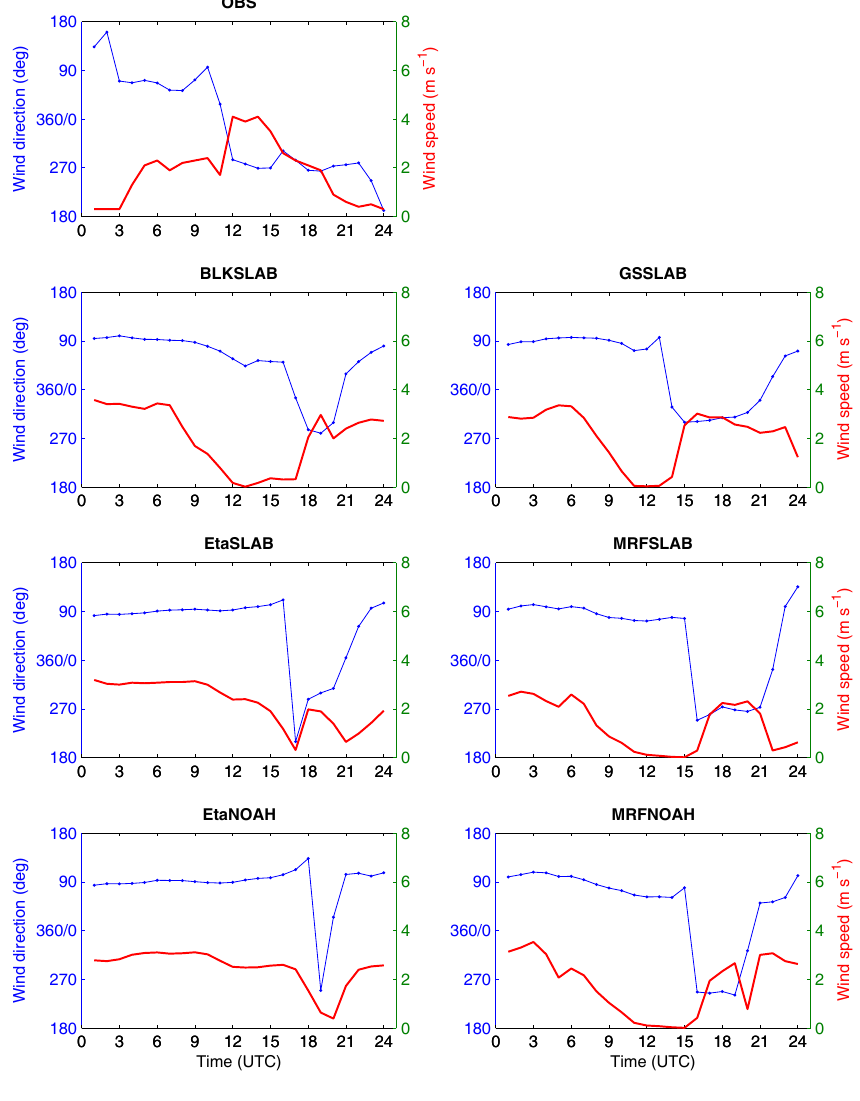
Fig. 5. Same as Fig. 2 but at ˚Aby